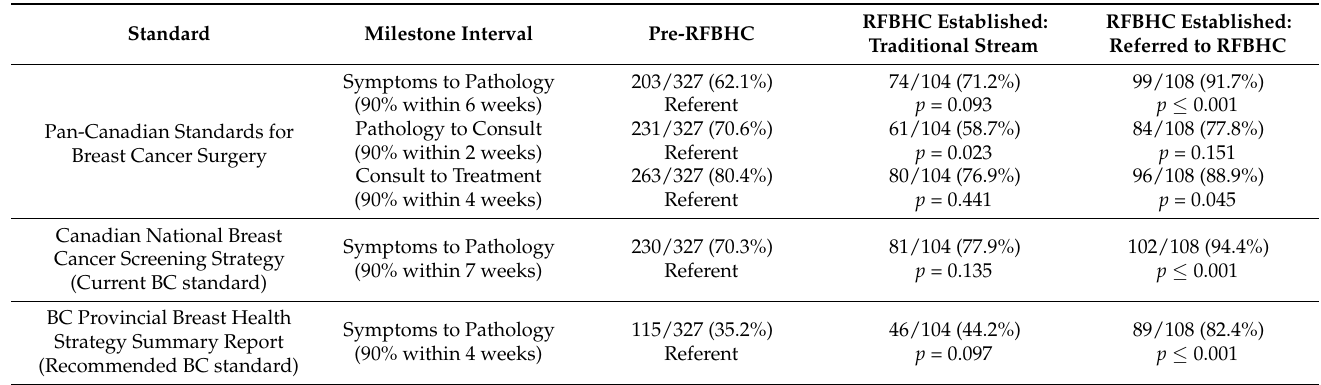
Table 3. Comparative compliance with Pan-Canadian [53] and Provincial [54,55] breast cancer wait time standards between study groups.